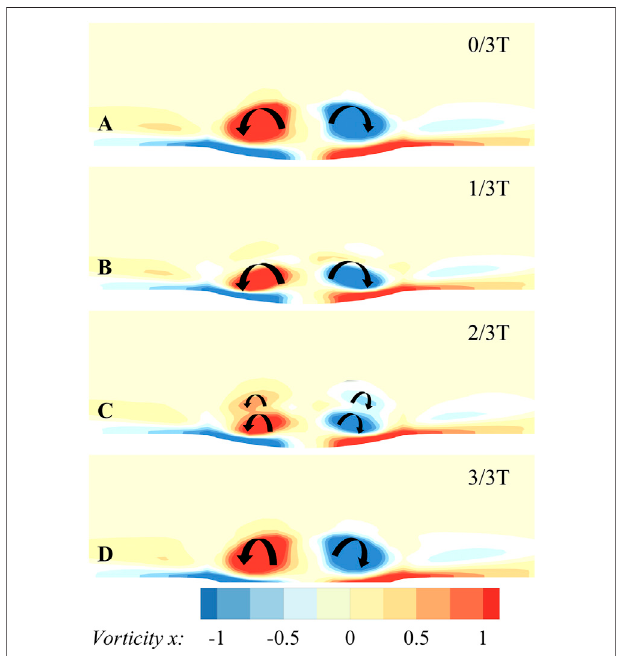
FIGURE 14 | Streamwise vorticity contours at the dimple trailing edge during one shedding periodicity.